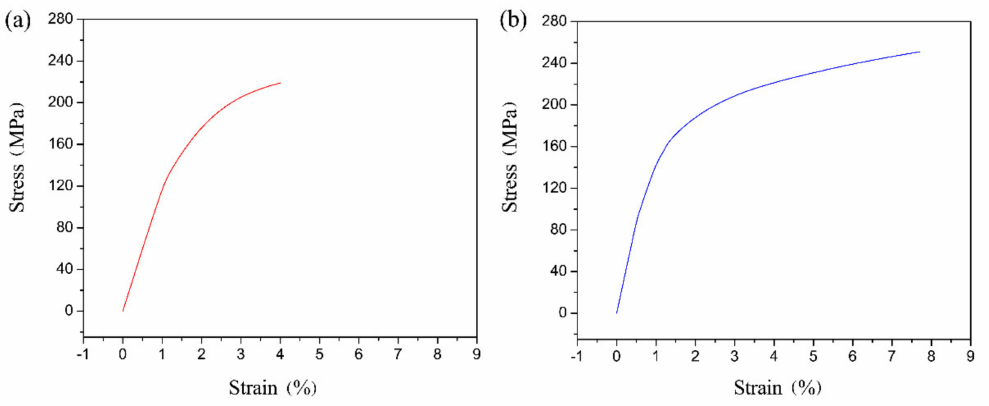
Figure 11. The tensile stress/strain curves of the galvanized steel/AZ31B joints: ( a ) a current of 65 A and without UVAW, ( b ) a current of 65 A and ultrasonic power of 0.9 kW.